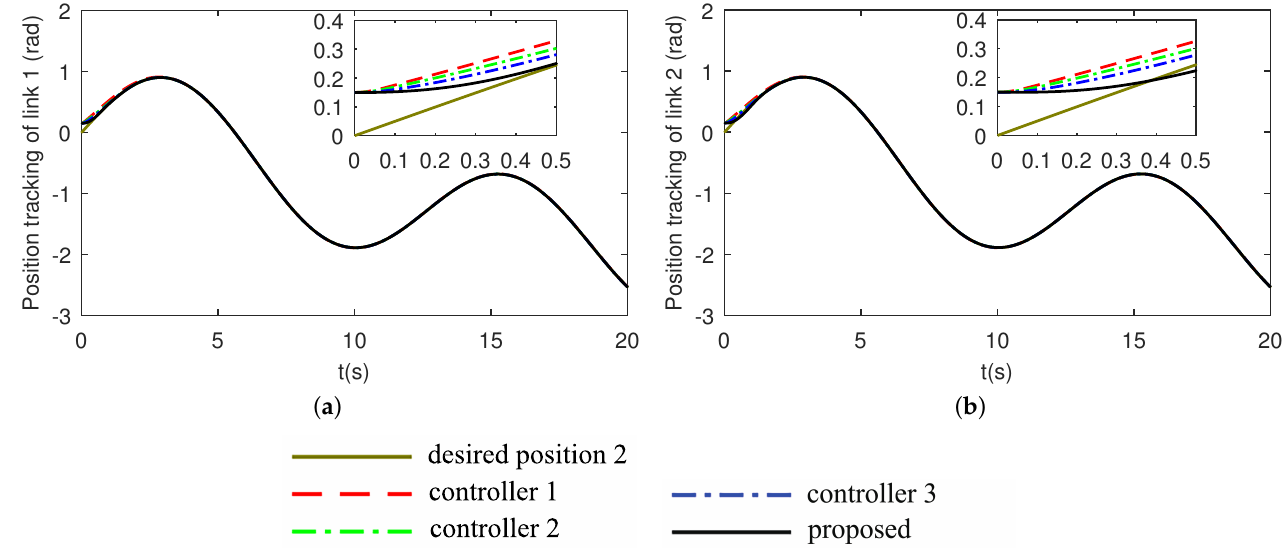
Figure 3. Position tracking performance with disturbances: ( a ) Link 1. ( b ) Link